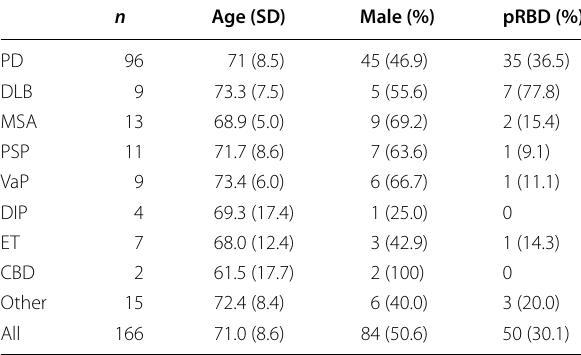
Table 3 Demographics of the 166 patients subjected to receiver operating characteristic (ROC) curve